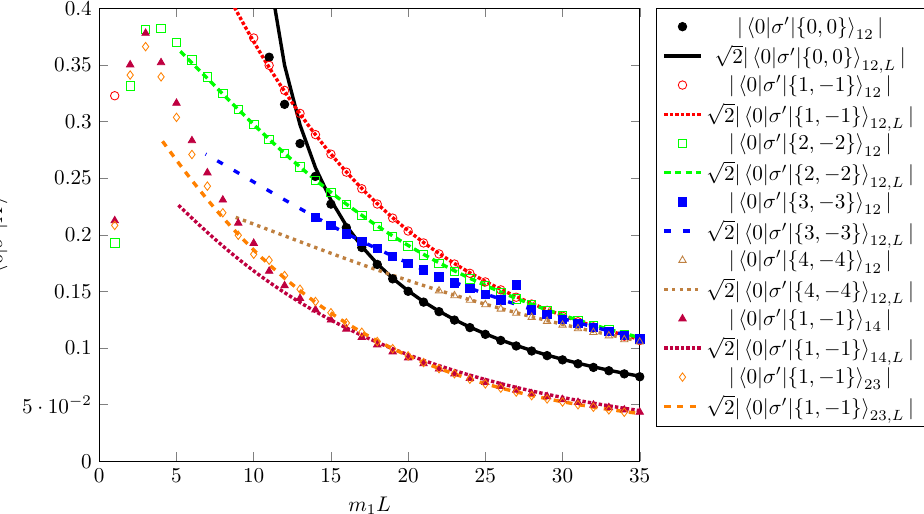
= 1) determined from TCSA (plot- Figure 6.2: Matrix elements 〈 0 | σ (cid:48) | X 〉 (in units m 1 ted with discrete markers), compared with finite volume form factors of two-particle states corresponding to different total momentum zero solutions to the Bethe–Yang equations (shown with lines). As discussed in Appendix C.2, the main source of error in this comparison are the exponential finite volume corrections to the matrix elements. The outlier point in the matrix element 〈 0 | σ (cid:48) |{− 3,3 }〉 is due to the vicinity of the same level crossing as in Fig.